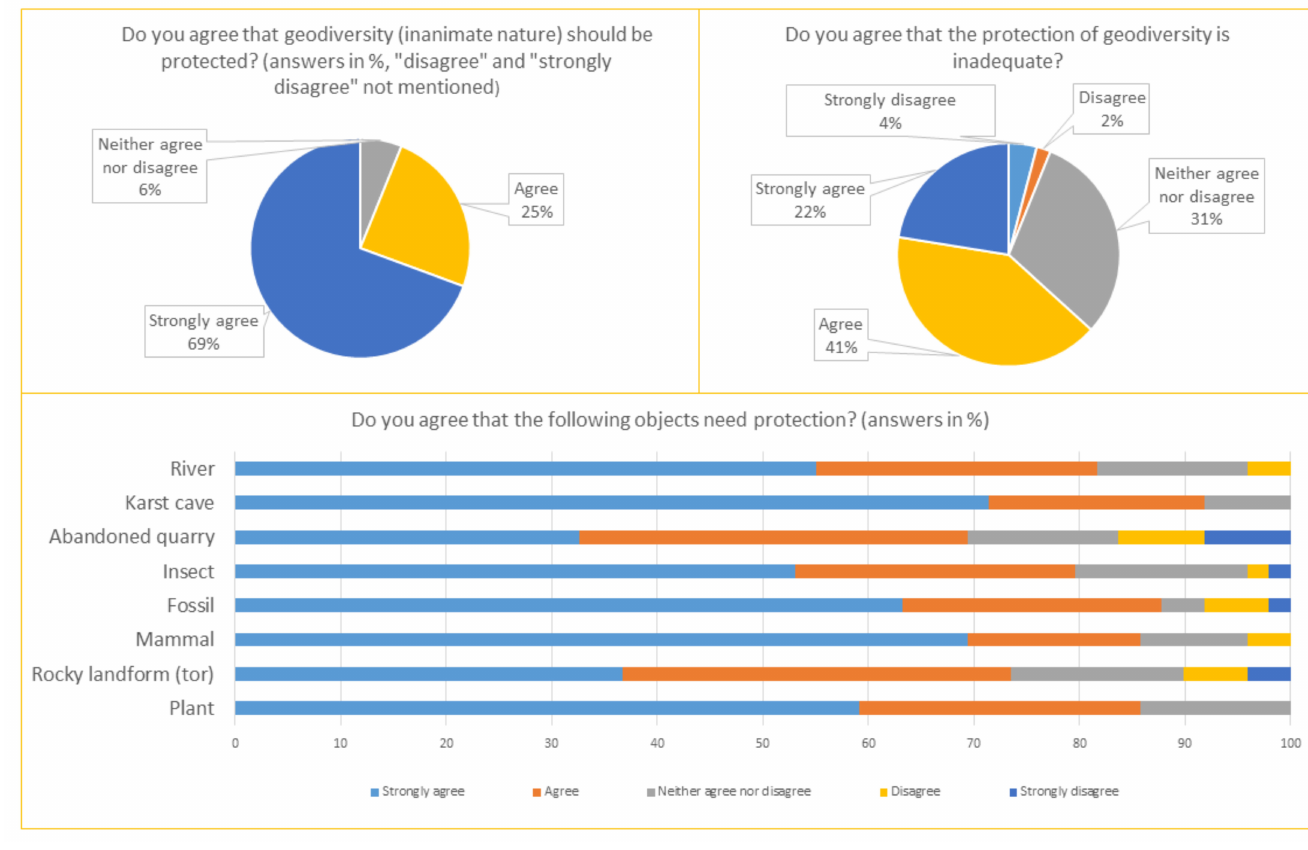
Figure 2. The results of the first group of questions. The differences between the need of protection for particular objects; there is a remarkable difference in opinion on the protection of abiotic nature—in some cases the abiotic components of the nature are not estimated as those that need the